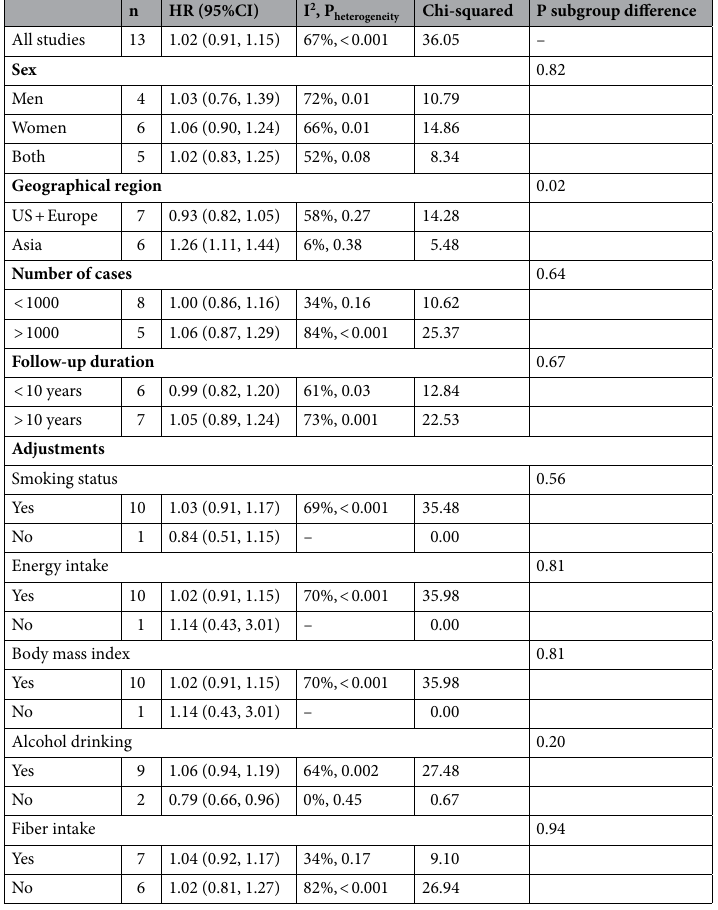
Table 1. Subgroup analyses of dietary carbohydrate and the risk of type 2 diabetes (highest versus lowest category meta-analysis).